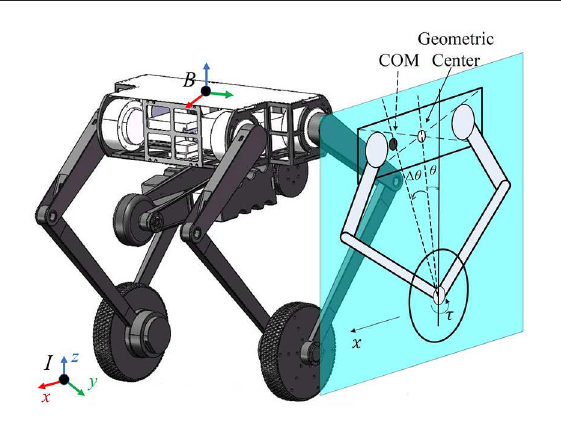
FIGURE2 Mechanical design of the robot Ollie and simplified model on the sagittal plane, where the geometric center and the CoM are marked in a hollow circle and a filled circle, respectively. The actual pitch angle ¯ θ is the subtraction of the measured value θ and an offset 1θ , i.e., θ = θ − 1θ . The displacement of the robot in the x direction is denoted as x with its velocity ˙ x . The wheel is actuated by the motor torque τ .